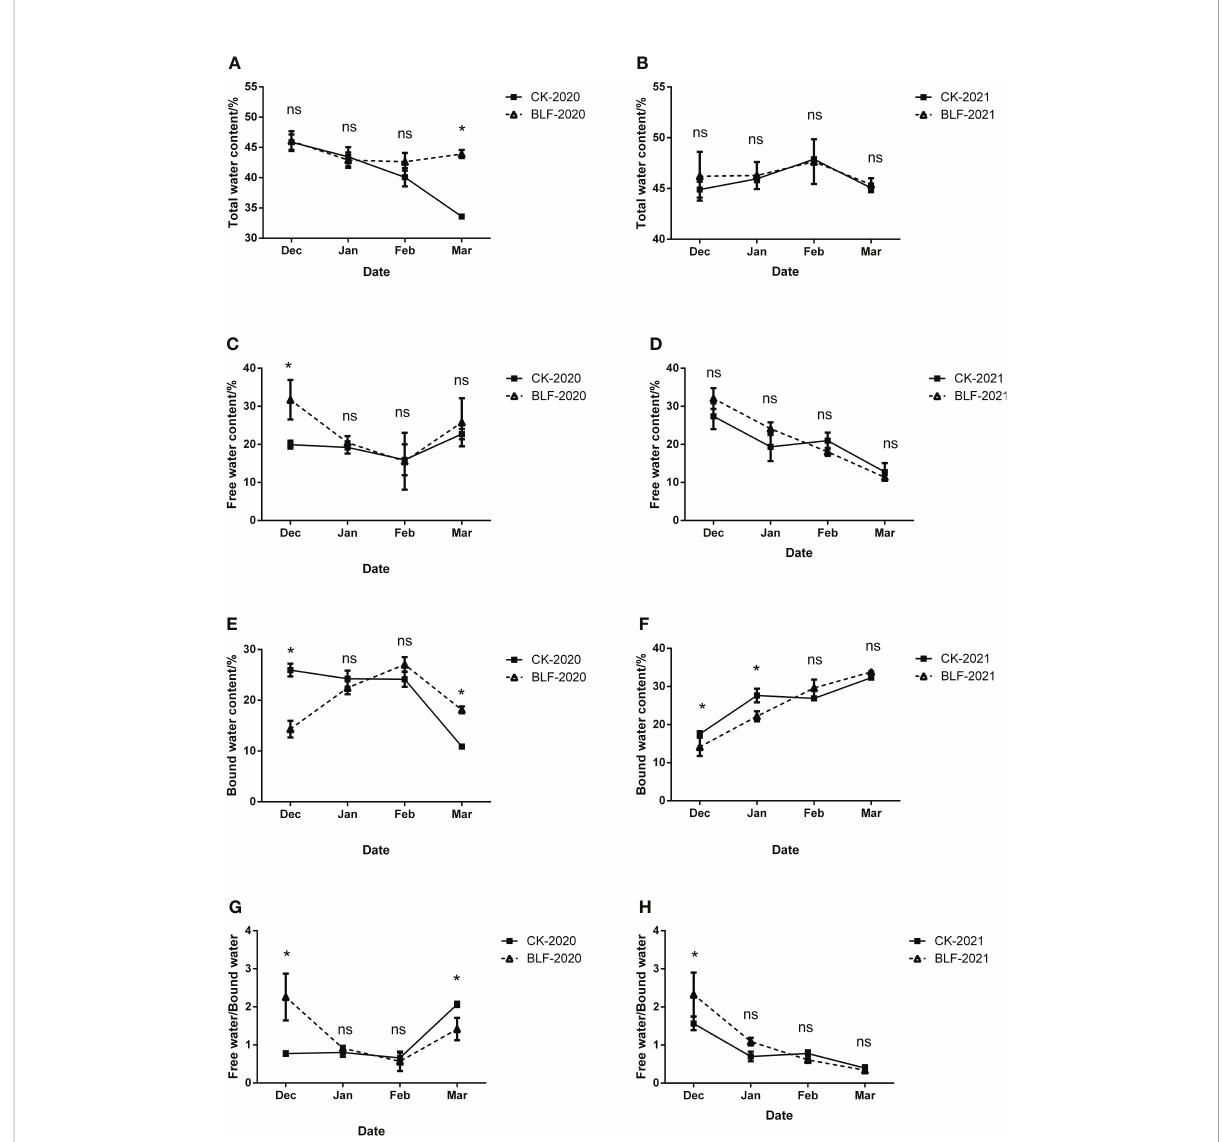
FIGURE 2 The effect of spraying BLF on the content of total water (A, B) , free water (C, D) , bound water (E, F) , and the ratio of free water to bound water (G, H) on 2020 and 2021. “ * ” means that the average value of each parameter is signi fi cant between the two treatments (p<0.05), and ns means no signi fi cance by Duncan ’ s multiple range test.